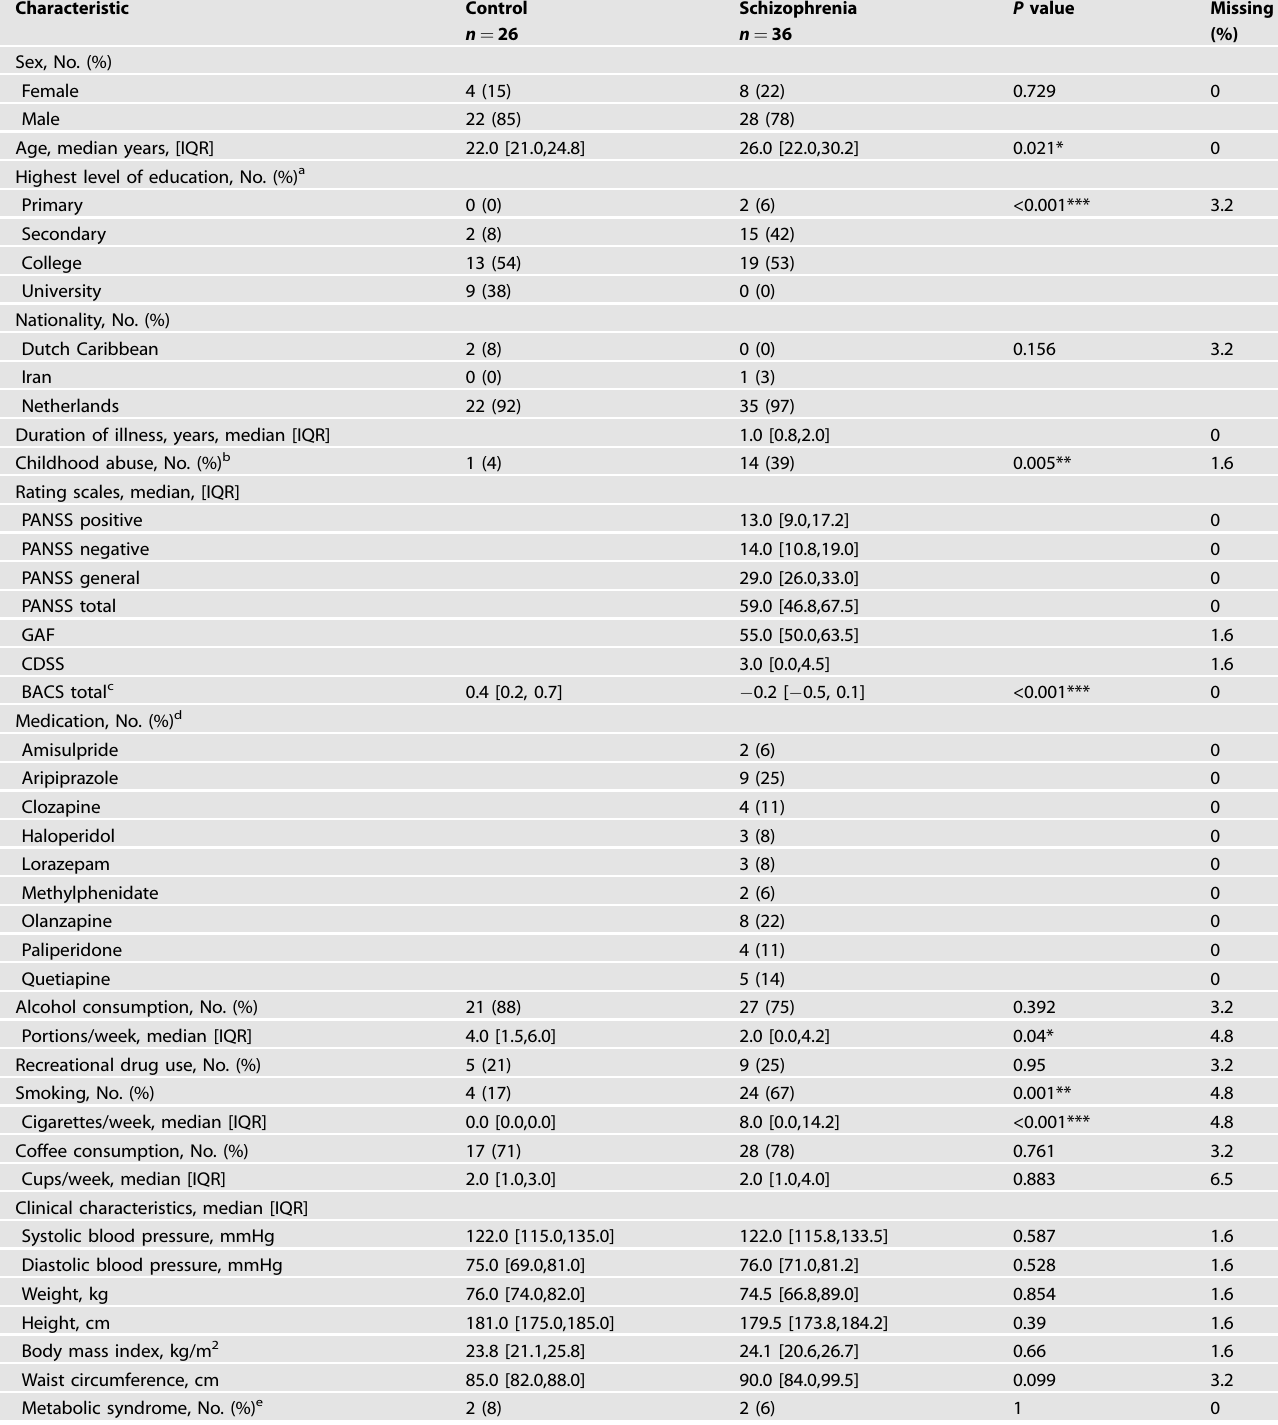
Table 1. Demographic and clinical characteristics of healthy control participants and schizophrenia patients.